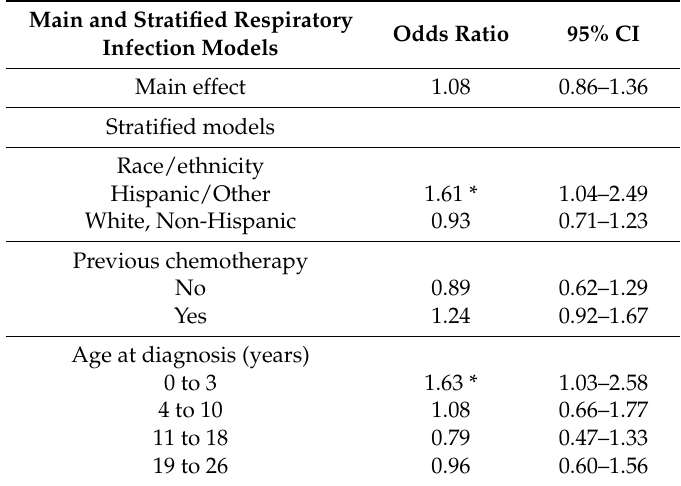
Table 5. Odds ratios and 95% confidence intervals (CI) for the main and stratified effects of a 10 µ g/m 3 increase in PM 2.5 with respiratory infections among survivors of childhood